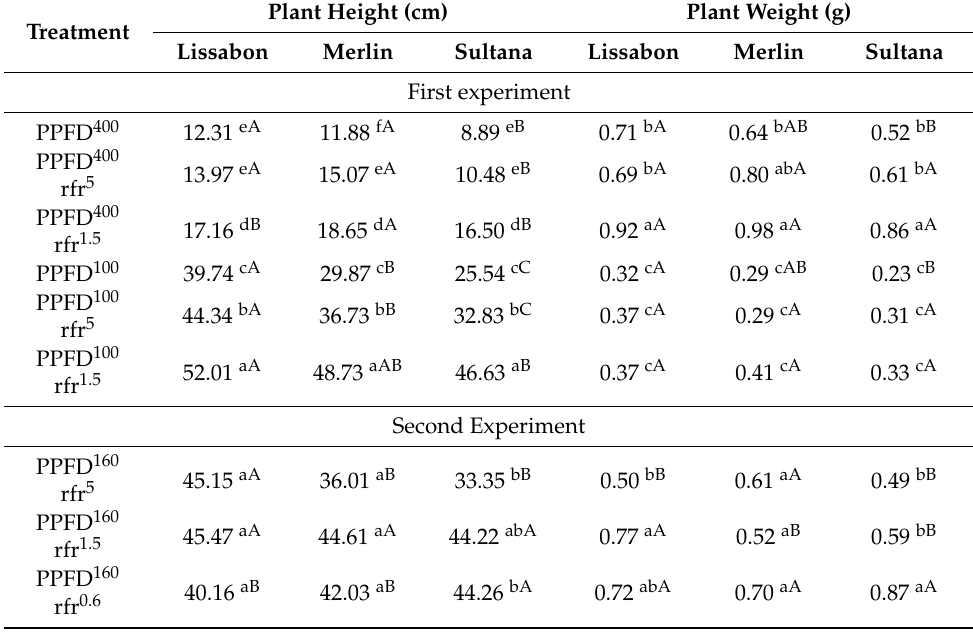
Table 3. The least square means of plant height and weight for the three cultivars in the first (top) and second (bottom) experiment. For each experiment, lower case letters indicate significant di ff erences between treatments for each cultivar, and upper case letters indicate significant di ff erences between cultivars for each treatment ( p <